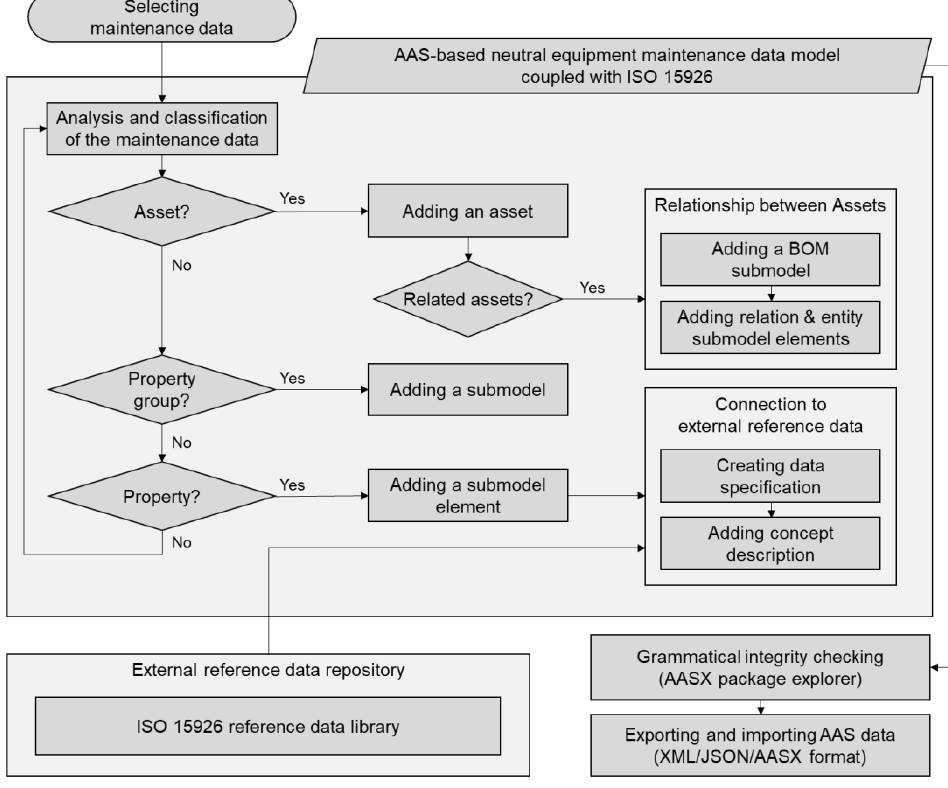
Figure 1. Research scope and procedures.